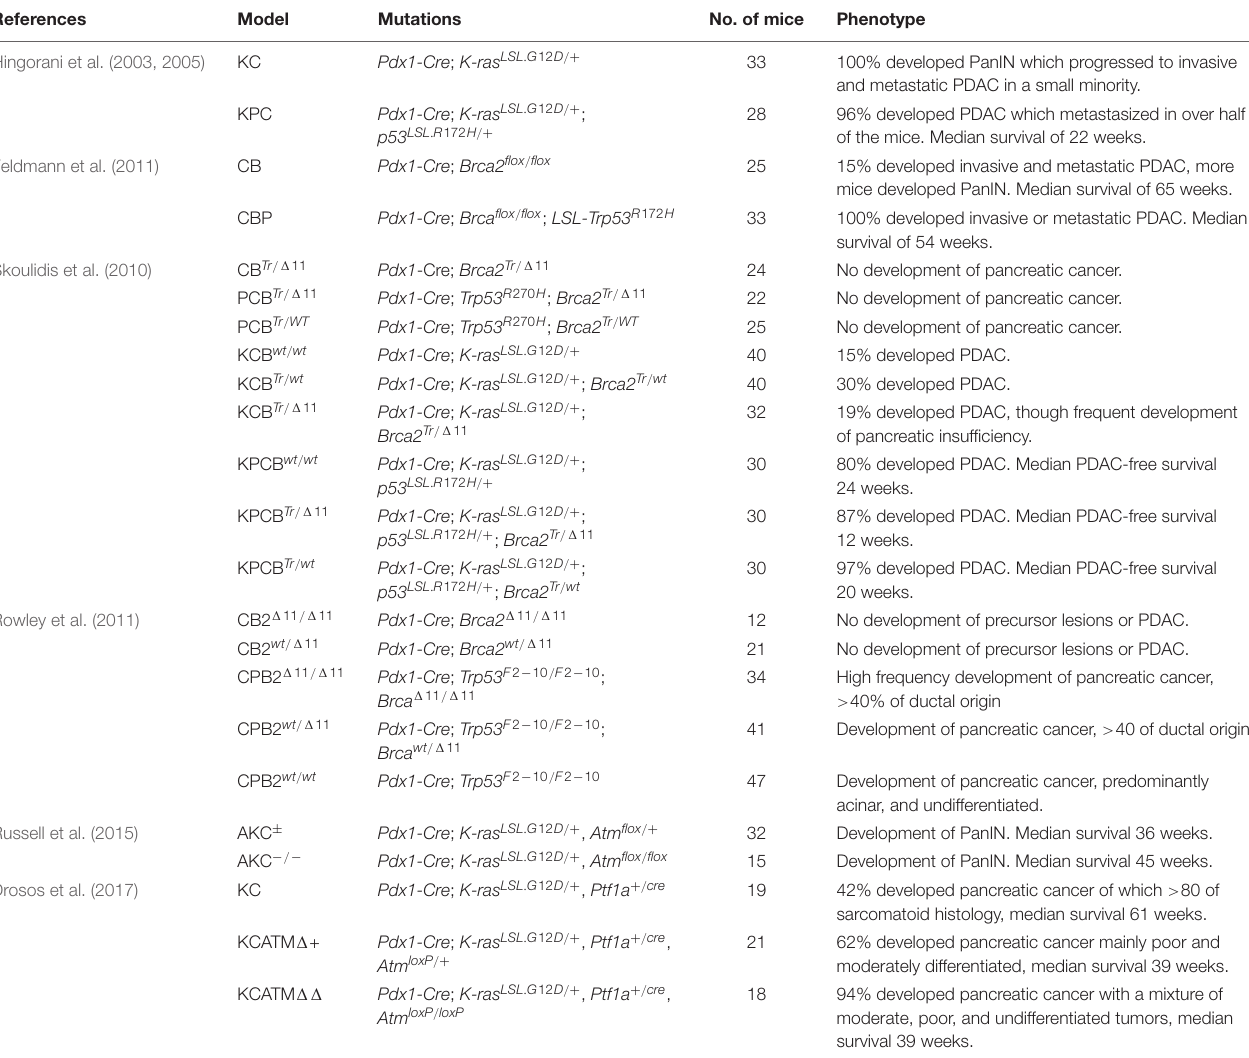
TABLE 3 | Overview DDR deficient pancreatic cancer GEMMs